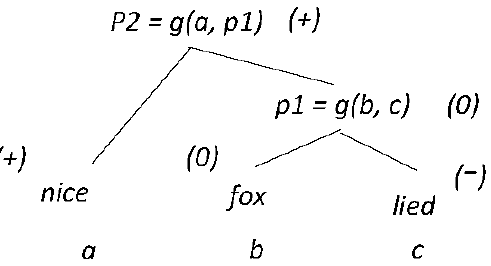
Figure 1. Approach of Recursive Neural Network Model, based on [41], predicting the sentiment classes of “Negative” (−), “Neutral” (0), and “Positive” (+). Sentiment classes in the figure are examples, not actual computed output.